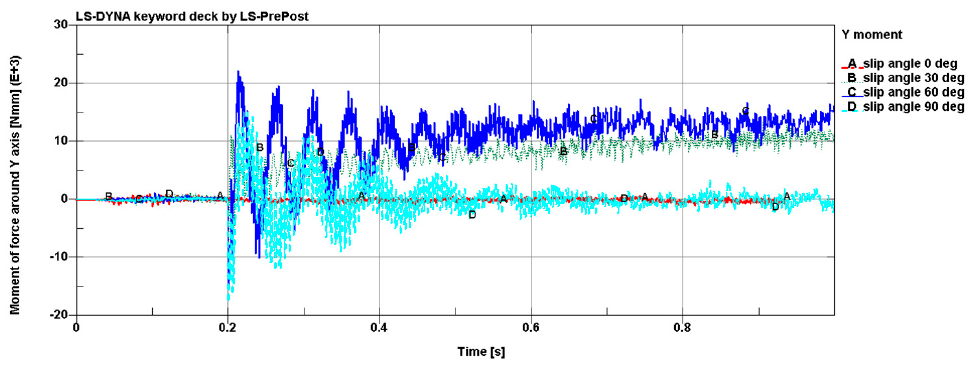
Figure 14. Moments of the forces around the y-axis for the range of slip angles.